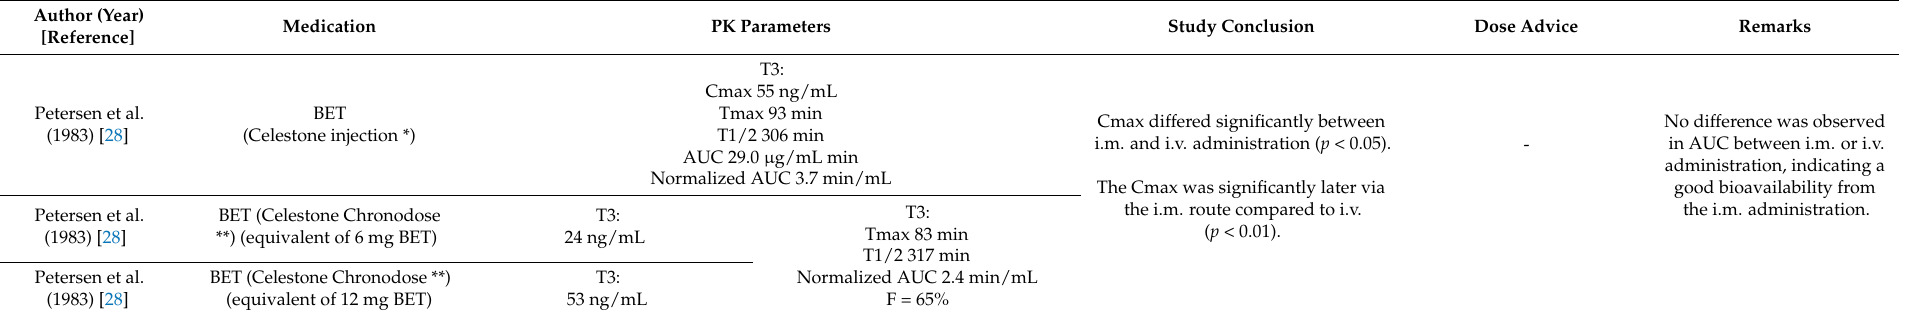
Table A4. Summary of the pregnancy-induced changes in the pharmacokinetics of IBD-related drugs. The data are presented as mean (SD), median (IQR) or alternative method, indicated next to the corresponding value. Each row is dedicated to one medicine. When a column overlaps multiple rows, the data are shared over multiple